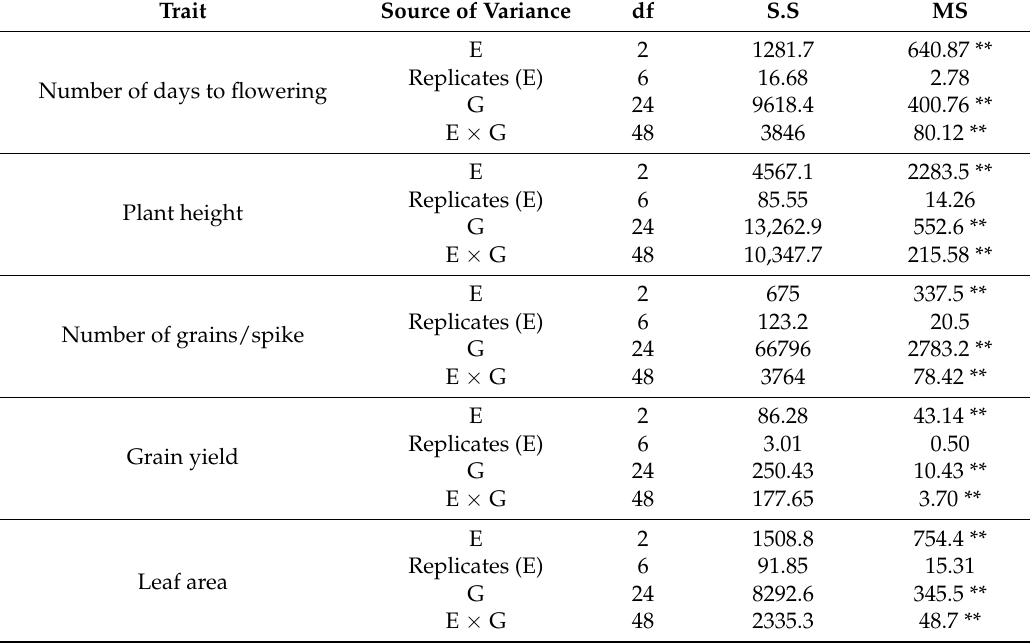
Table 3. Combined analysis of variance for the number of days to flowering, plant height (cm), number of grains/spike, grain yield (tons/ha), and leaf area (cm 2 ) of 25 barley genotypes (G) across three environments